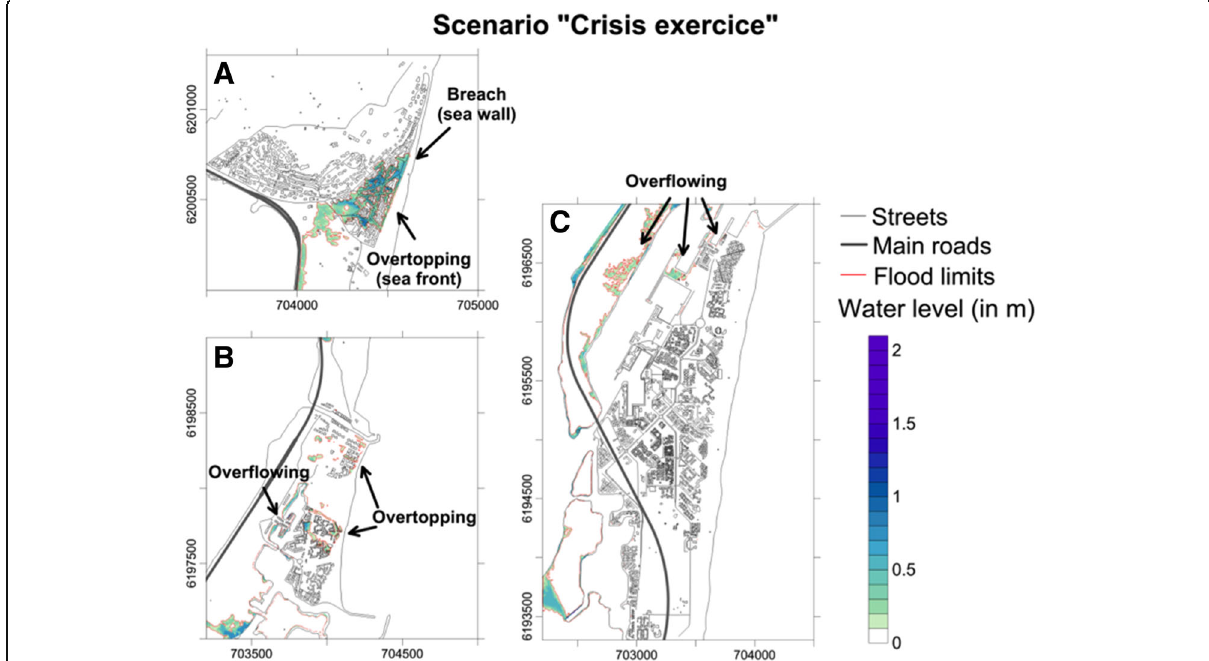
Fig. 3 Submersion scenario, a Leucate Plage, b naturist village, c Port Leucate, created from the digital model and used for the March 2016 field